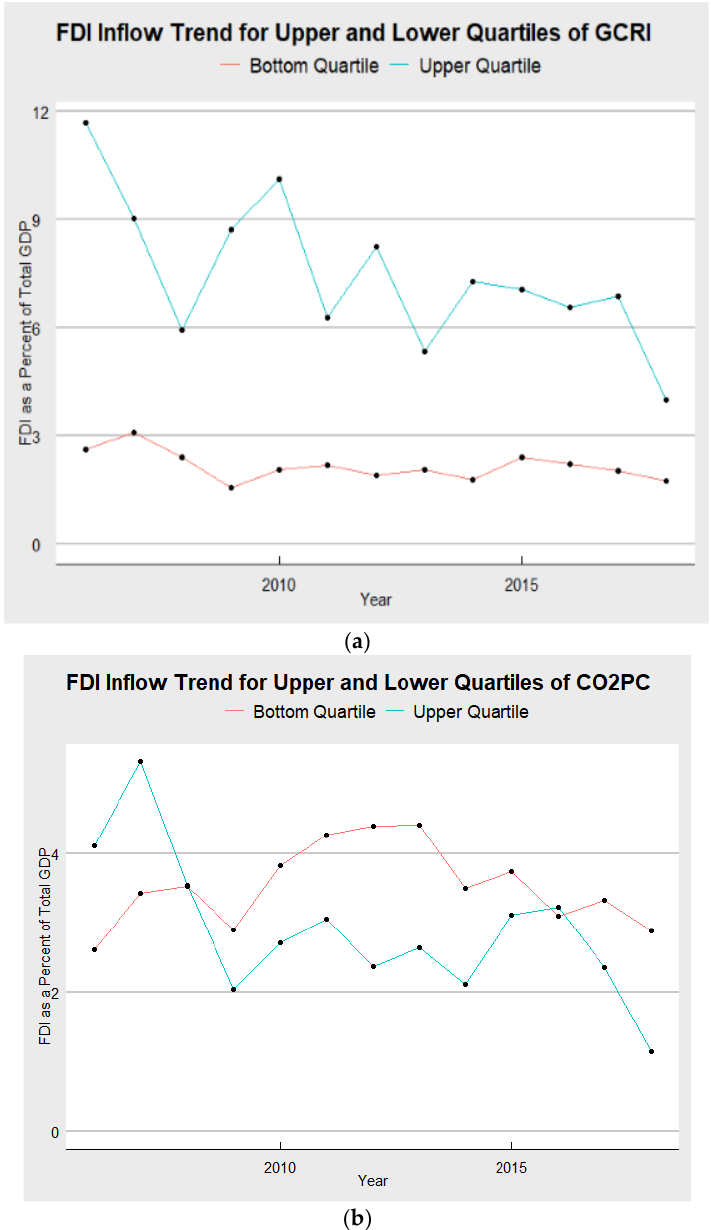
Figure 4. GCRI and CO2PC and FDI inflows: ( a ) climate risk (GCRI); ( b ) carbon emissions (CO2PC).